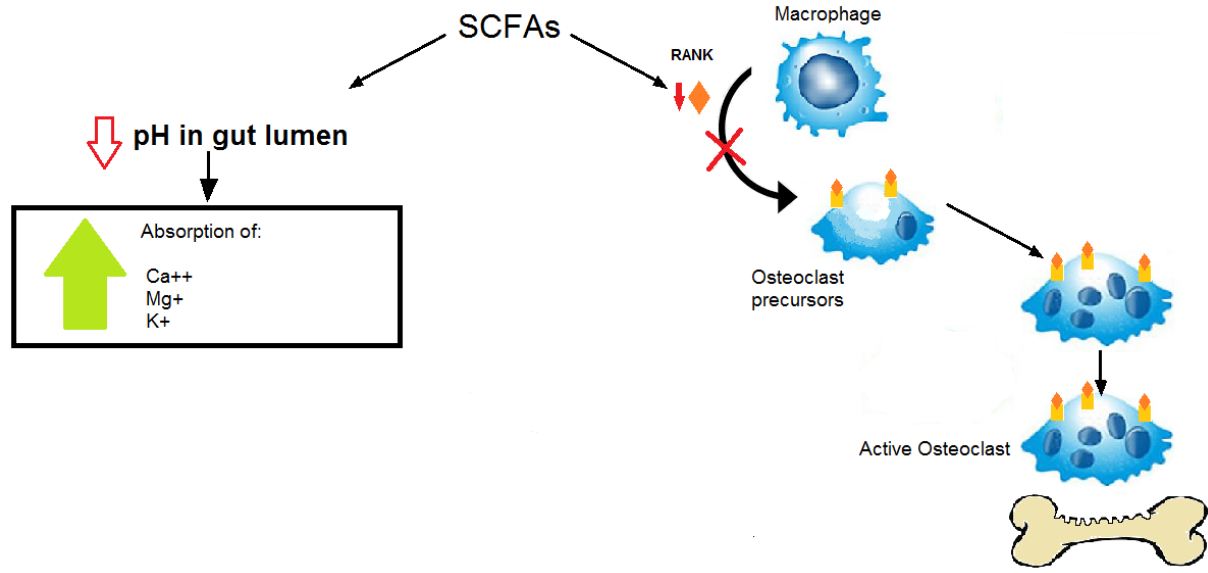
Figure 2. SCFAs play a very important role in bone formation and mineralization by acting on the osteoprotegerin path- way, reducing osteoclastogenesis by suppressing the RANKL pathway, and reducing the pH of the intestinal tract by subsequently increasing the absorption of